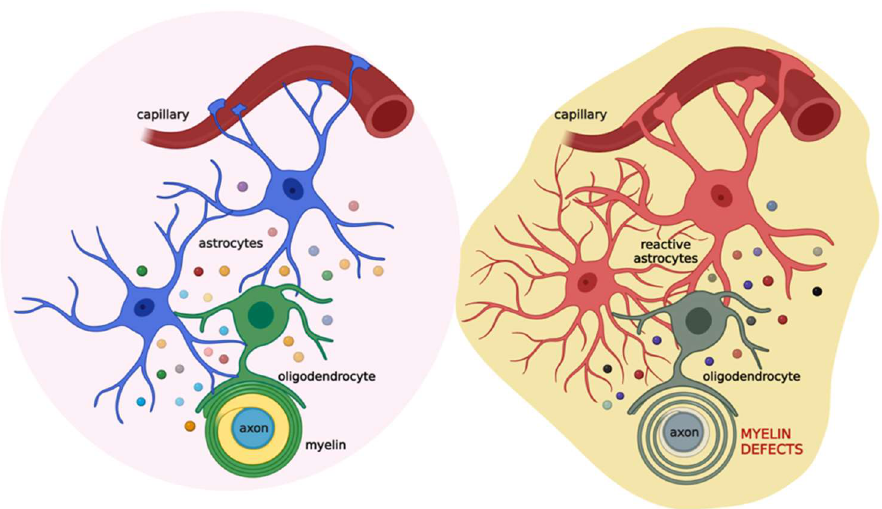
Figure 3. Schematic illustration of the coupling of oligodendrocytes, astrocytes, and neurons in physiological (left) and pathological (right) conditions. Astrocytes (blue) communicate with oligodendrocytes (green) through gap junctions and several released factors (colored circles), such as PDGF, BDNF, CNTF, TGF- β , FGF2, TIMP-1, ILs, TNF- α , and IFN- γ . This cross-talk allows the proper maturation of oligodendrocytes and their ability to form the myelin sheath. This, in turn, impacts neuronal activity. When brain damage occurs (see text for details), astrocytes (red) react promptly, affecting oligodendrocytes (grey) activity and ultimately the myelin sheath. Created with BioRender.com (accessed on 22 July